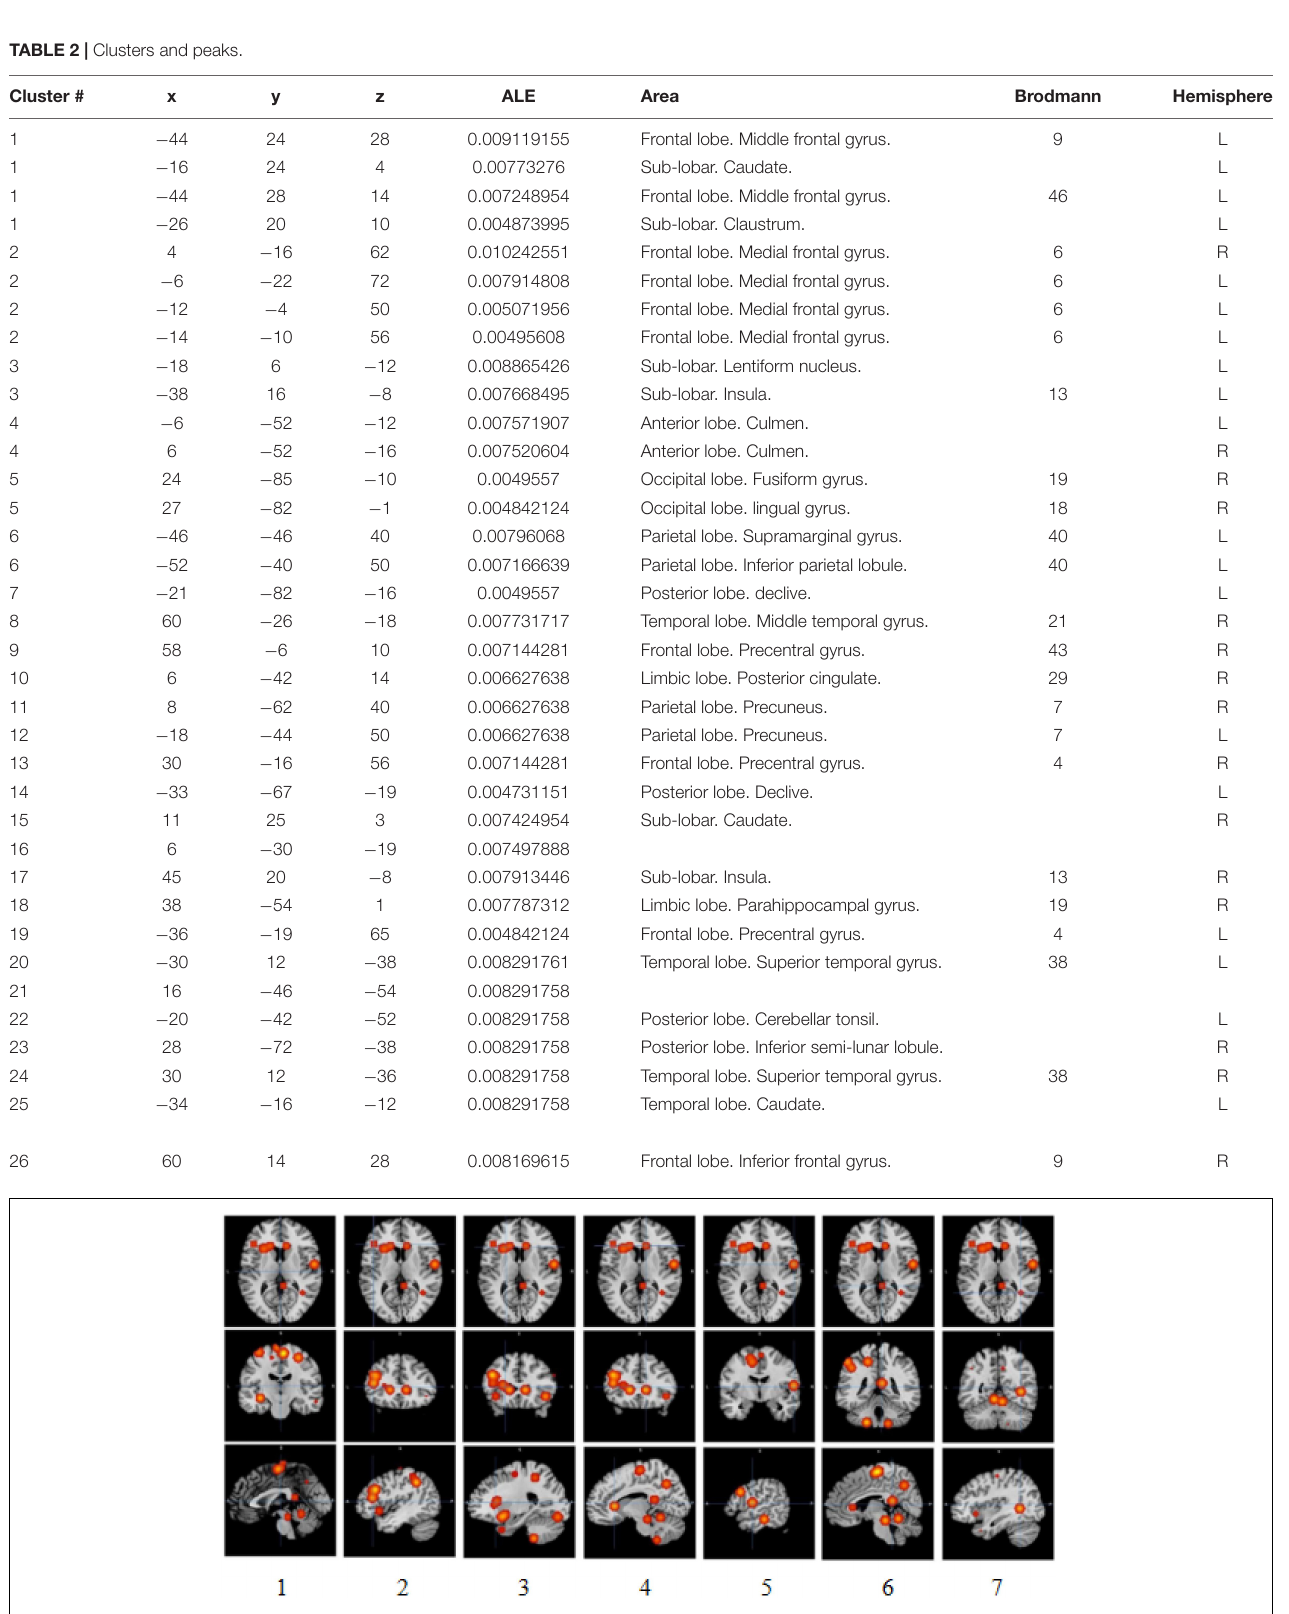
FIGURE 2 | Slice view of clusters. 1, 2, 3, 4, 5, 6, and 7, respectively, indicate activation clusters that have reached a significant activation level.